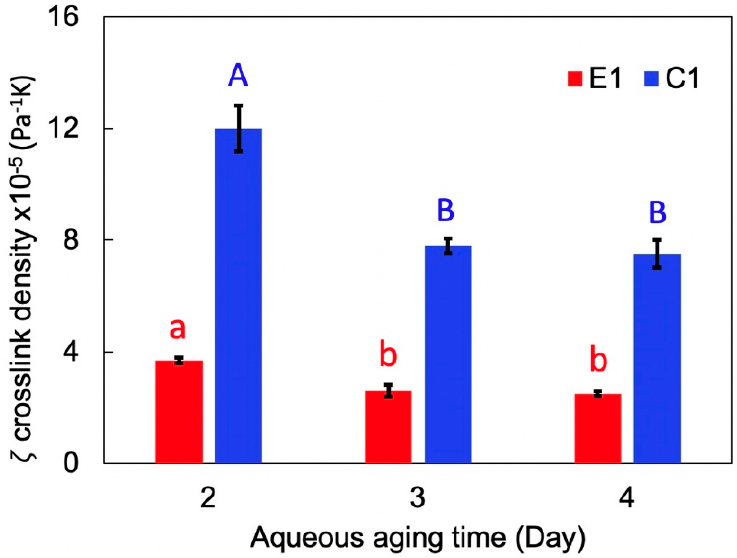
Figure 4. Relative crosslink density of water-saturated copolymers in wet condition. Same letter indicates no statistically significant difference ( p < 0.05).